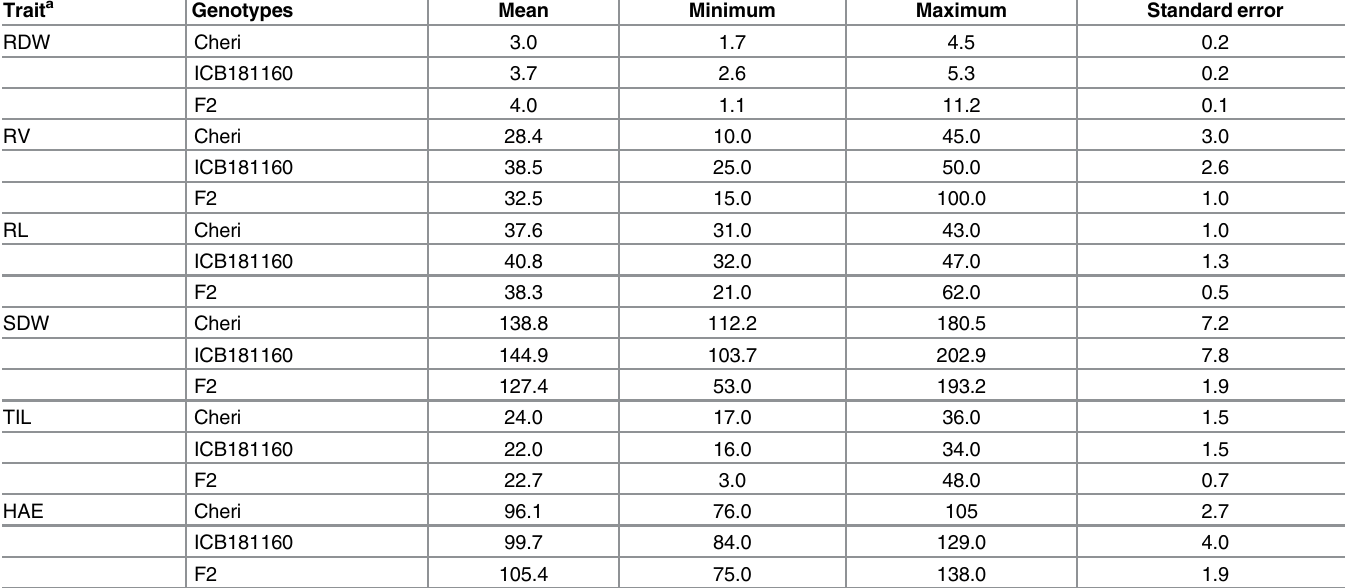
Table 1. Mean comparisons of the root and shoot traits among Cheri, ICB181160 and the F2 population. Trait a Genotypes